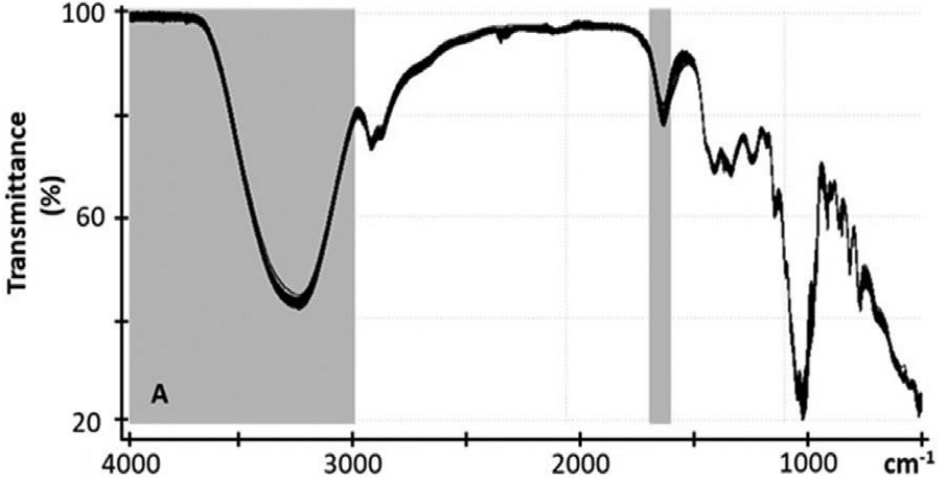
Figure 1. The FTIR spectra of honey samples from Romania and France regions, where the areas excluded are presented in gray. (Reprinted with permission from Ref [24]).